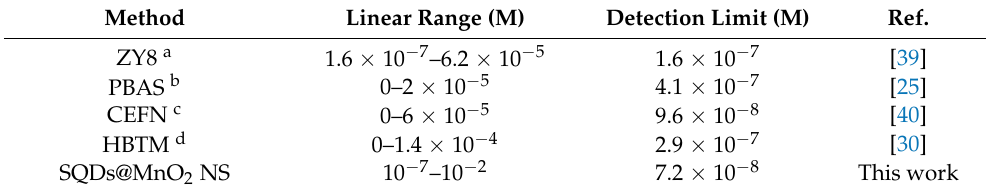
Figure 6. ( a ) The response of SQDs@MnO 2 NS fluorescent probe to N 2 H 4 solution with different concentrations (0.1 µ M–10 mM); ( b ) The linear relationship between fluorescence intensity and N 2 H 4 concentrations. Table 1. Comparison of several different methods for N 2 H 4 detection.